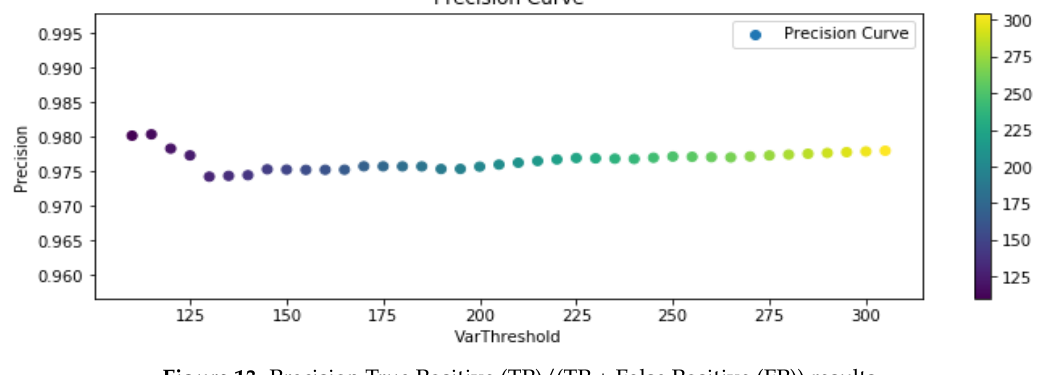
Figure 13. Precision True Positive (TP)/(TP + False Positive (FP)) results.